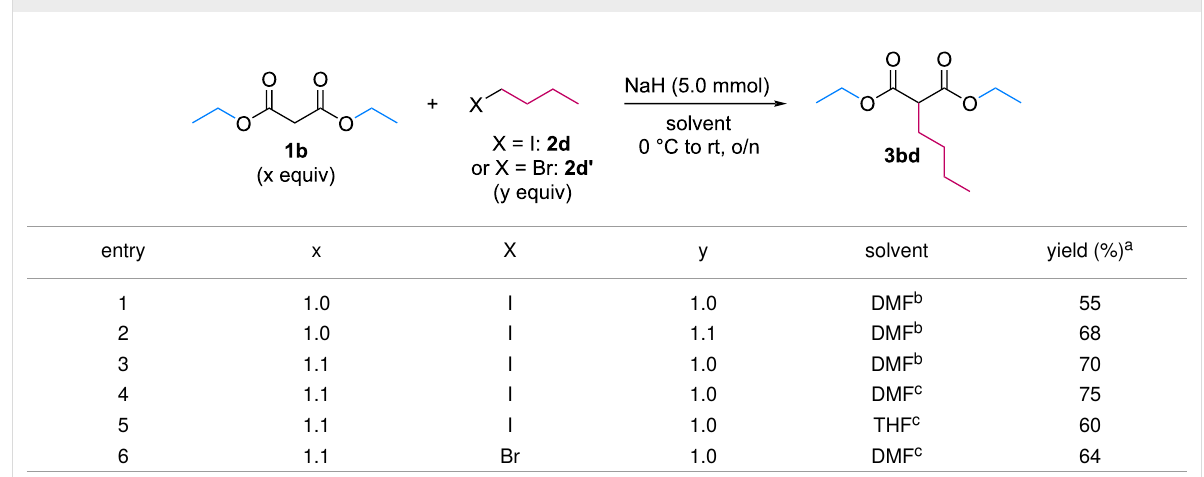
Table 1: Optimization of the alkylation step.